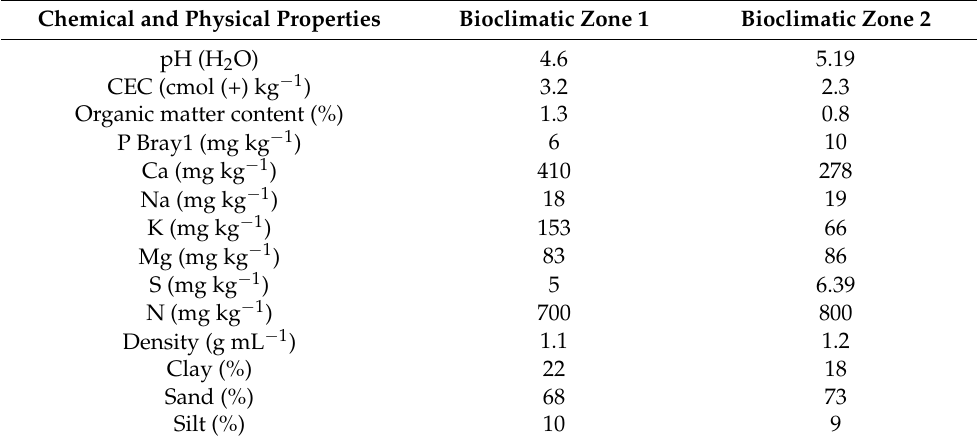
Table 1. Chemical and physical properties of different bioclimatic zones of the experiments at a depth of 0–60 cm of the soil